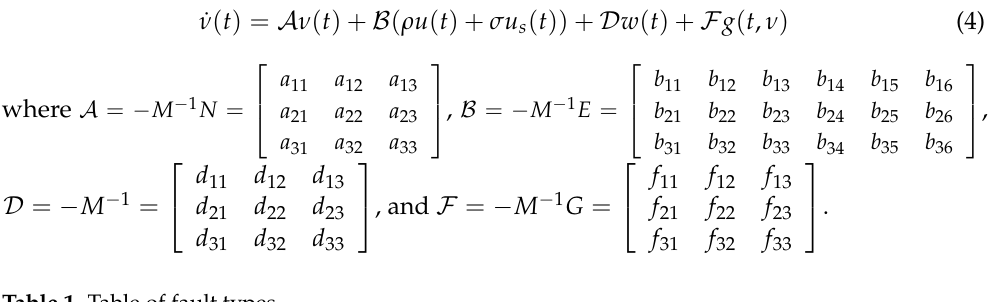
Table 1. Table of fault types.